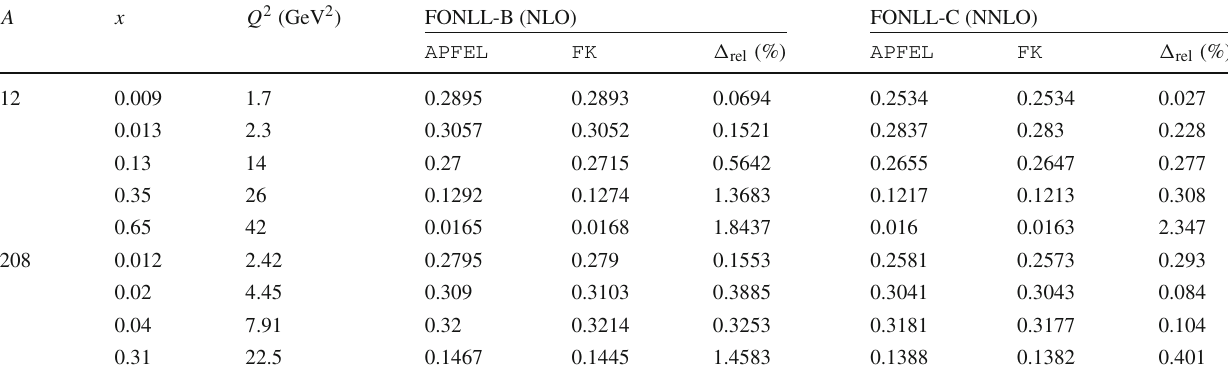
Table 3 Comparison between the deep-inelastic structure function F 2 ( x , Q 2 , A ) computed with the APFEL program and with the cor- responding FK interpolation tables. The predictions are given for two different perturbative orders, FONLL-B and FONLL-C, and are com- puted using the EPPS16 nPDF set with theoretical settings described